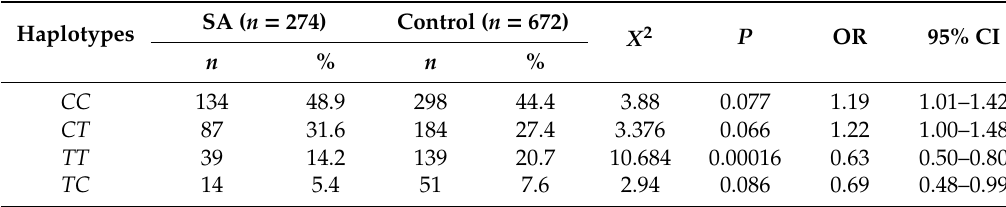
Table 5. IL-20 haplotype frequencies in SA and healthy